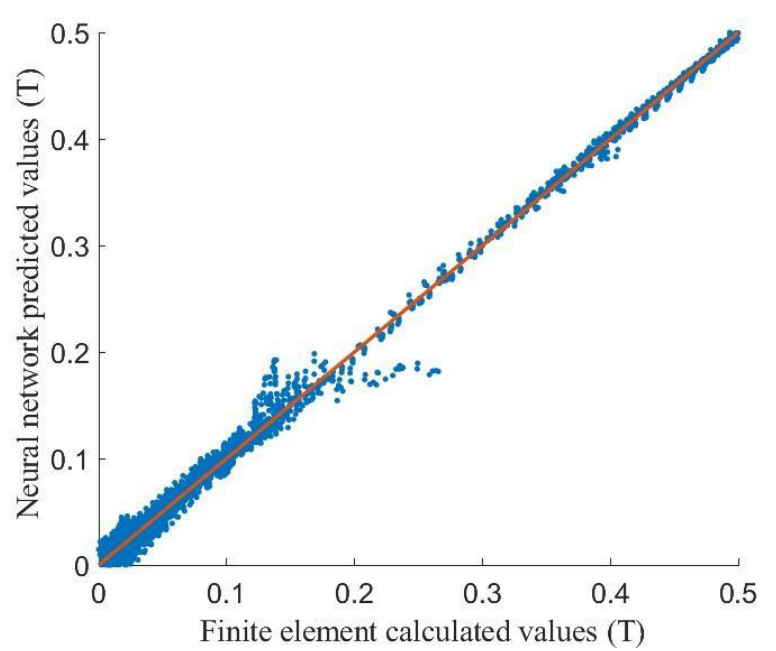
Figure 8. Comparison of magnetic flux density values of inductor with magnetic core.